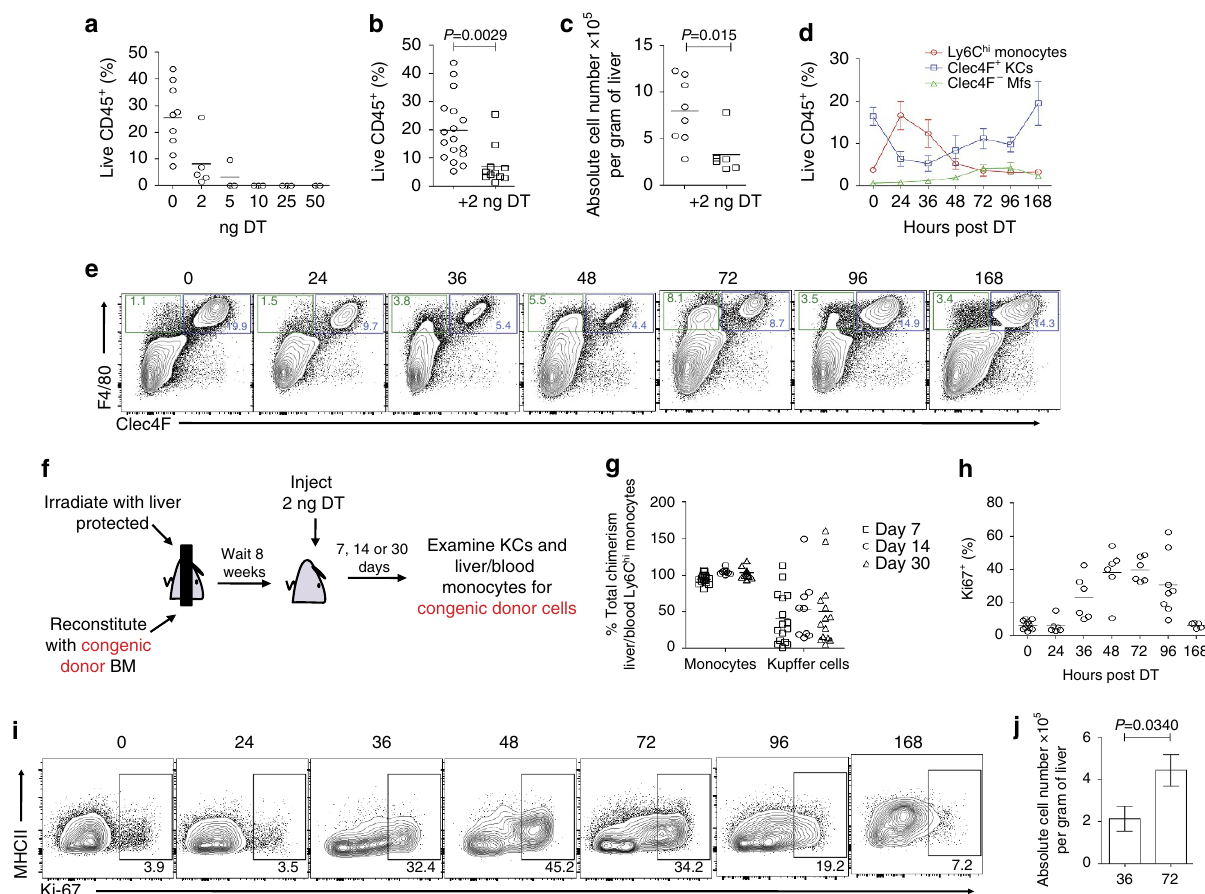
Figure 4 | Mo-KCs compete with em-KCs for KC niche repopulation after partial depletion. ( a ) Percentage of KCs among live CD45 þ cells 24h following administration of various doses of DT. Data are from one experiment. n ¼ 9 (0ng), 5 (2ng), 3 (5, 10, 25ng) or 2 (50ng). ( b ) Percentage of KCs among live CD45 þ cells in KC-DTR or WT littermate controls 24h post administration of 2ng DT. Data are pooled from 3 experiments. n ¼ 17 (control)